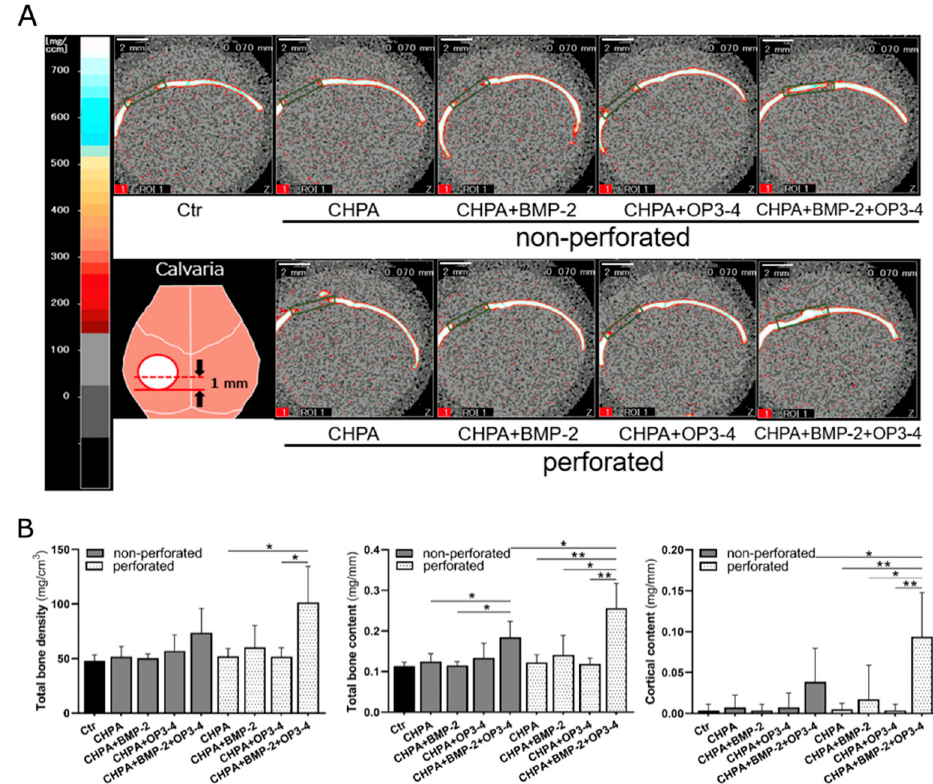
Figure 4. pQCT confirmed the higher bone mineral content in the perforated scaffold group: ( A ) pQCT images of newly formed bone in the calvarial defect model. The dotted line in the diagram of the lower-left panel illustrates the measurement site. Frontal section images at the site of the dotted line are shown. The green square indicates the region of interest (ROI) where bone density and other parameters were measured. Scale bar = 2 mm; See the Figure 2 legend for group names. ( B ) Quantitative data of the pQCT at the ROI of the bone defect site. Total bone density: total bone mineral density; Total bone content: total bone mineral content; Cortical area: cortical bone area. Normality was analyzed by the Shapiro–Wilk test. Comparisons between groups were performed using the Wilcoxon rank sum test. Values are expressed as the mean ± SD, * p < 0.05, ** p < 0.01.